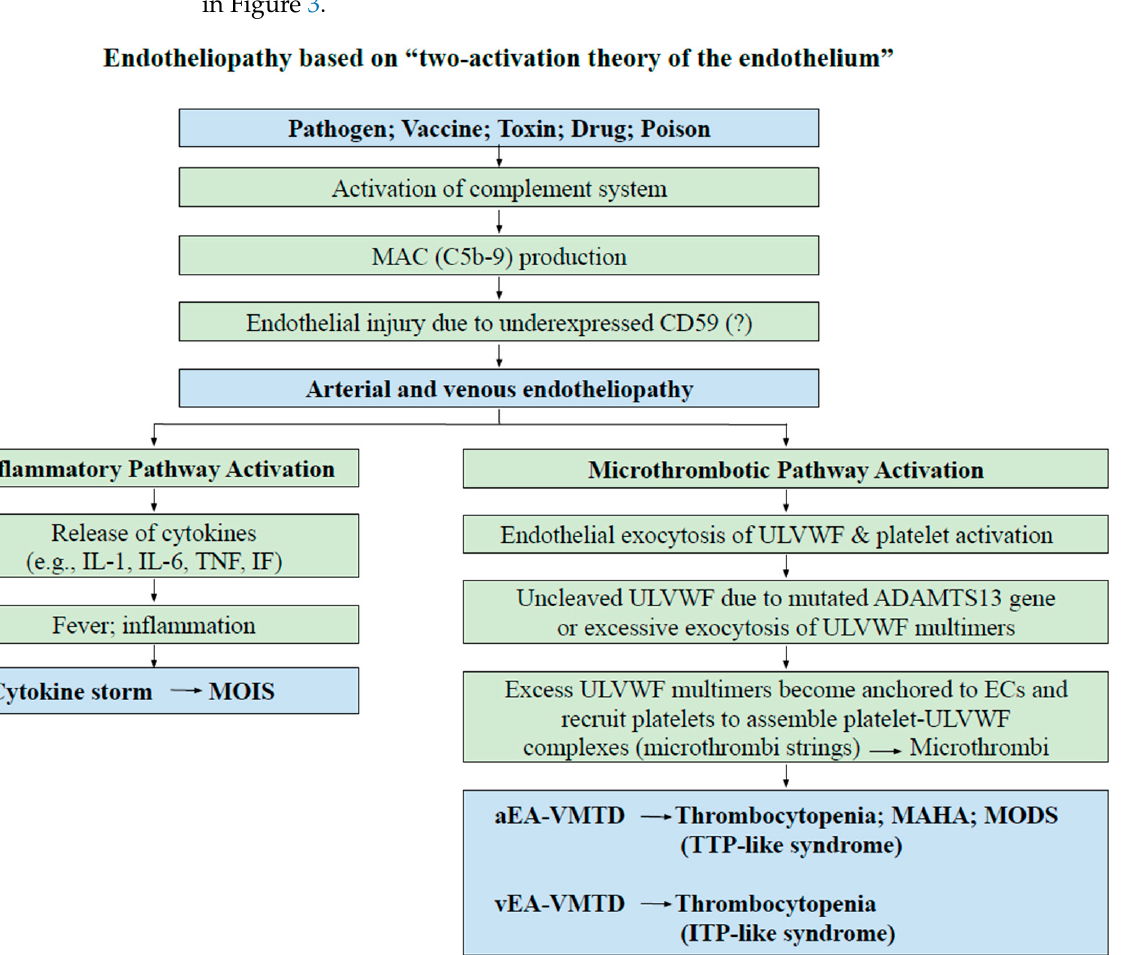
Figure 2. Endotheliopathy based on “two-activation theory of the endothelium”. Endothelial molecular pathogenesis is initiated by activation of complement system triggered from pathogen, vaccine, toxin, drug, poison, or others. However, unlike pathogen-induced sepsis, vaccine-induced clinical syndrome is almost always due to venous endotheliopathy because it has produced ITP-like syndrome rather than TTP-like syndrome occurring in arterial endotheliopathy as explained in the text. These distinguishing features are caused by differences in physiological function and hemodynamic characteristics between the arterial system and venous system. Therefore, MAHA and hypoxic MODS do not occur in vaccine-associated endotheliopathy. However, inflammatory syndromes (MOIS) such as myocarditis and pericarditis could occur after vaccination instead of hypoxic MODS. Abbreviations: ITP, immune thrombocytopenic purpura; MAC, membrane attack complex; IF, interferon; IL, interleukin; MAHA, microangiopathic hemolytic anemia; MODS, multiorgan dysfunction syndrome; MOIS, multiorgan inflammatory syndrome; TNF, tumor necrosis factor; TTP, thrombotic thrombocytopenic purpura; aEA-VMTD, arterial endotheliopathy-associated vascular microthrombotic disease; vEA-VMTD, venous endotheliopathy-associated vascular microthrombotic disease; ULVWF, unusually large von Willebrand factor